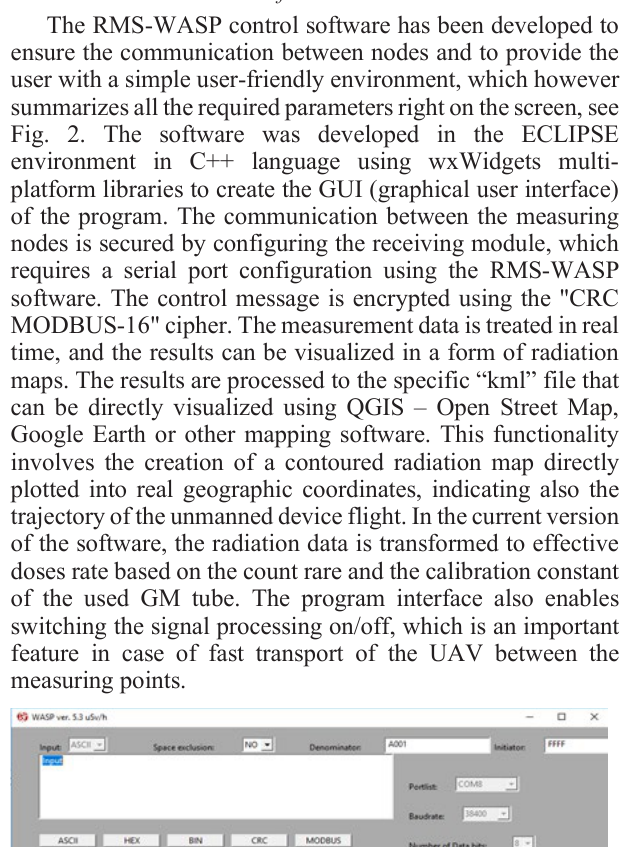
Fig. 1. 1. The schematic view of RMS modules.